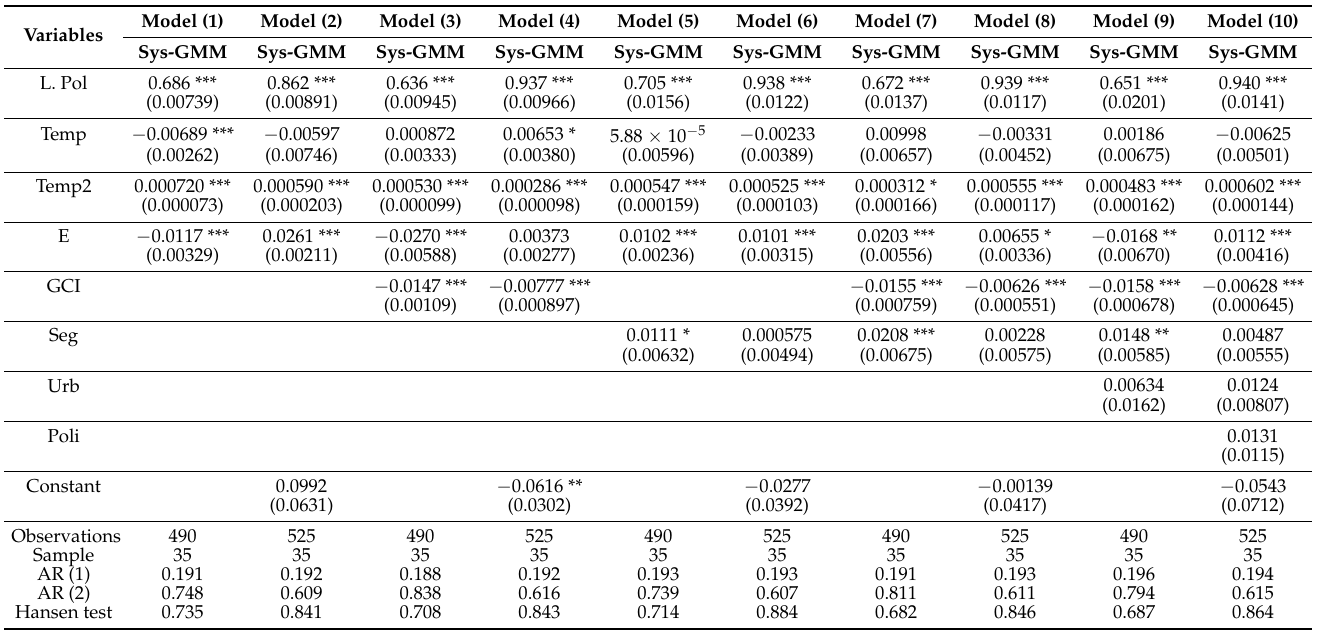
Table 7. The environmental pollution function (OECD).